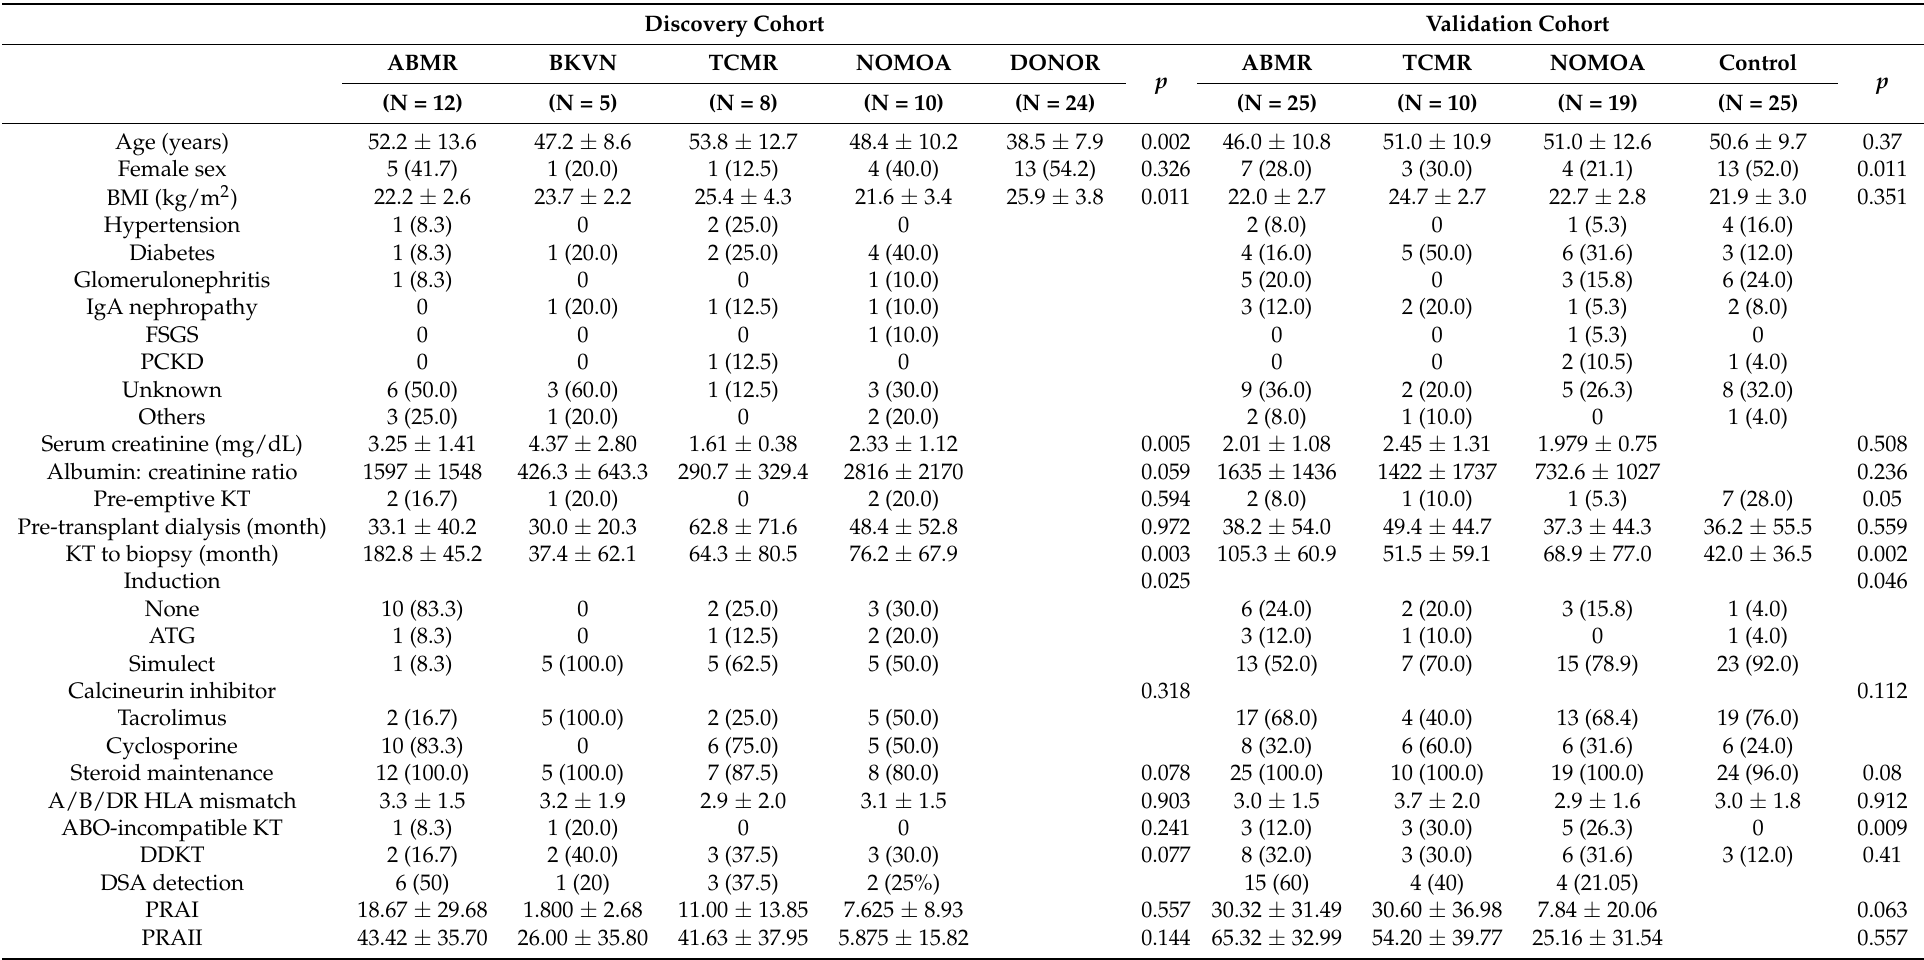
Table 1. Baseline characteristics according to pathologic